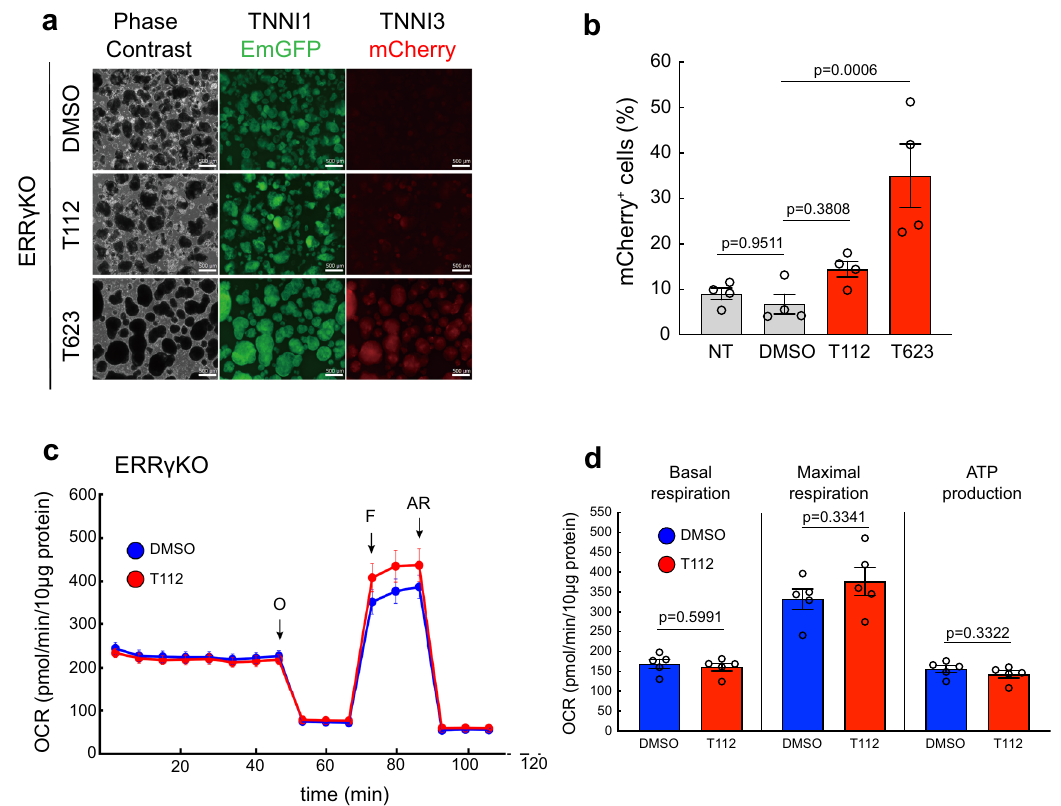
Fig. 6 Stage-speci fi c causal role of ERR γ in regulating TNNI3-driven cardiac maturation. a Fluorescence images of ERR γ KO hiPSC-CMs treated with DMSO, T112, or T623 for TNNI1 EmGFP and TNNI3 mCherry expression. Scale bars: 500 μ m. b Flow cytometric analysis of day-16 CMs derived from ERR γ KO hiPSCs for TNNI3 mCherry expression. n = 4 independent experiments per group. Data are the mean ± SEM; Statistical analysis was compared to DMSO using one-way ANOVA followed by Dunnett ’ s test. NT no treatment. c Mitochondrial respiration rates of ERR γ KO hiPSC-CMs treated with either DMSO or T112 (O Oligomycin ; F FCCP, phenylhydrazone ; AR Antimycin A and Rotenone ). n = 5 biologically independent samples per group. d Basal and maximal OCR and ATP production of ERR γ KO hiPSC-CMs treated with either DMSO or T112. Statistical analysis was done using unpaired two-tailed t -tests. n = 5 biologically independent samples per group. Data are the mean ± SEM; Statistical analysis was using unpaired two- tailed t -test.